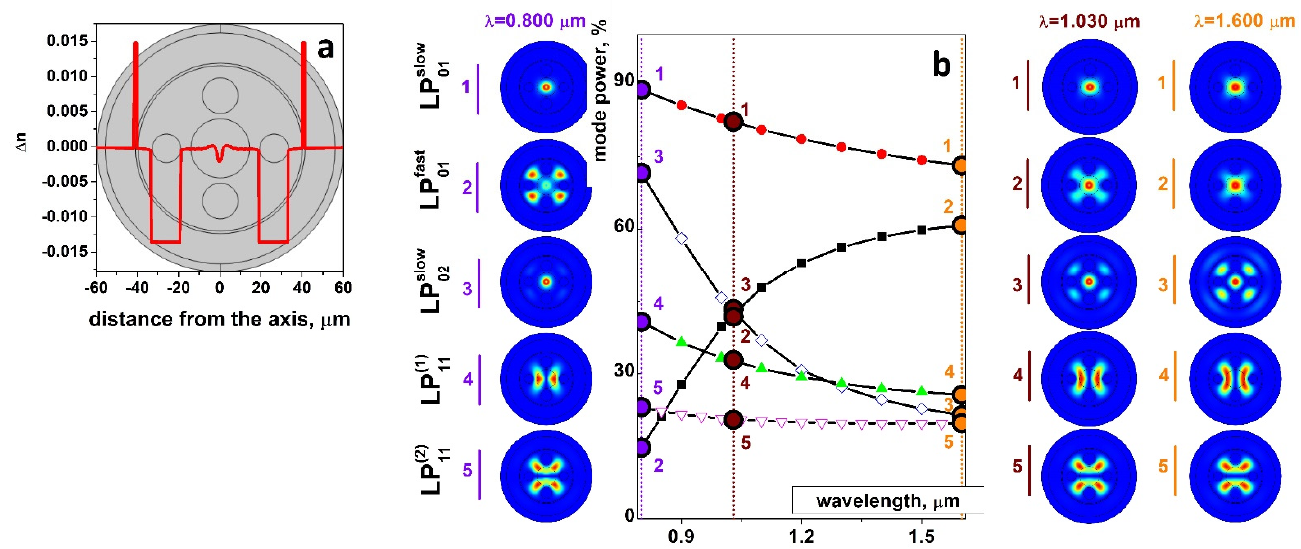
Figure 1. Designed refractive index profile of the fiber ( a ), outer layer corresponds to the PML, designed refractive index profile in the direction passing through B-doped rods (on the 1D-graph), refractive index contrast with respect to silica glass level ∆ n of B-doped rods was − 0.012, ∆ n of F-doped rods was − 0.004; ( b ) estimated modes’ power in the Yb-doped region and 2D images of modes’ field intensity distributions (power flow) at wavelengths of 0.8 μ m, 1.03 μ m and 1.6 μ m.